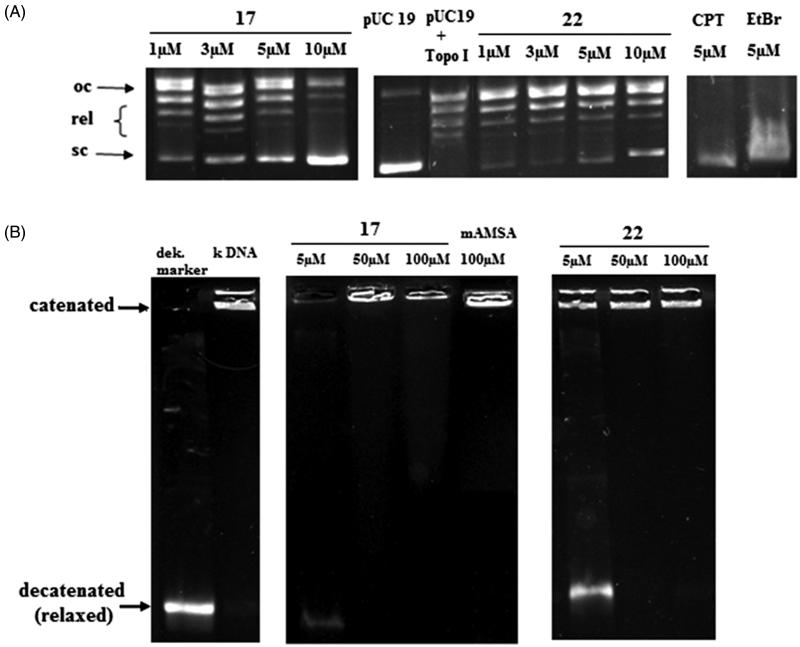
Effect of 17 and 22 on A: relaxation of supercoiled plasmid DNA by calf thymus Topo I. Supercoiled plasmid DNA pUC19 (lane pUC19) was incubated with calf thymus Topo I in the absence (lane pUC19 + Topo I) and in the presence of various compound concentrations (0–10 μM); B: decatenation of kDNA (0.16 μg) by human Topo IIα. Catenated kinetoplast DNA (lane kDNA) was incubated with human Topo IIα in the absence (lane kDNA + Topo II) and in the presence of various compounds concentration (0–100 μM).